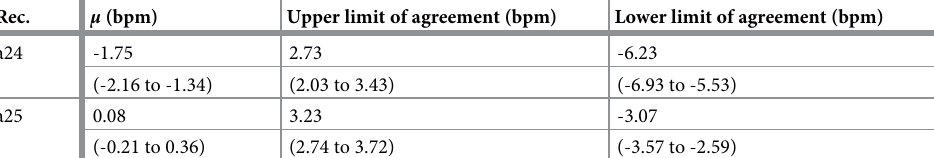
PLOS ONE | https://doi.org/10.1371/journal.pone.0256154 August 13,